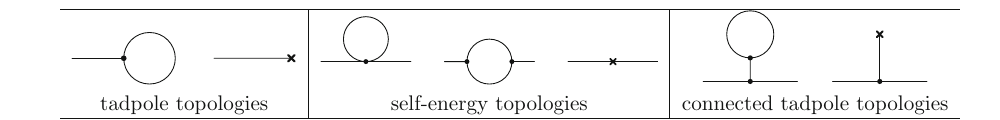
Fig. 1 left: one-loop tadpole diagrams; middle: one-loop self-energy diagrams appearing in standard and modified calculation; right: additional self-energy diagrams in the modified approach